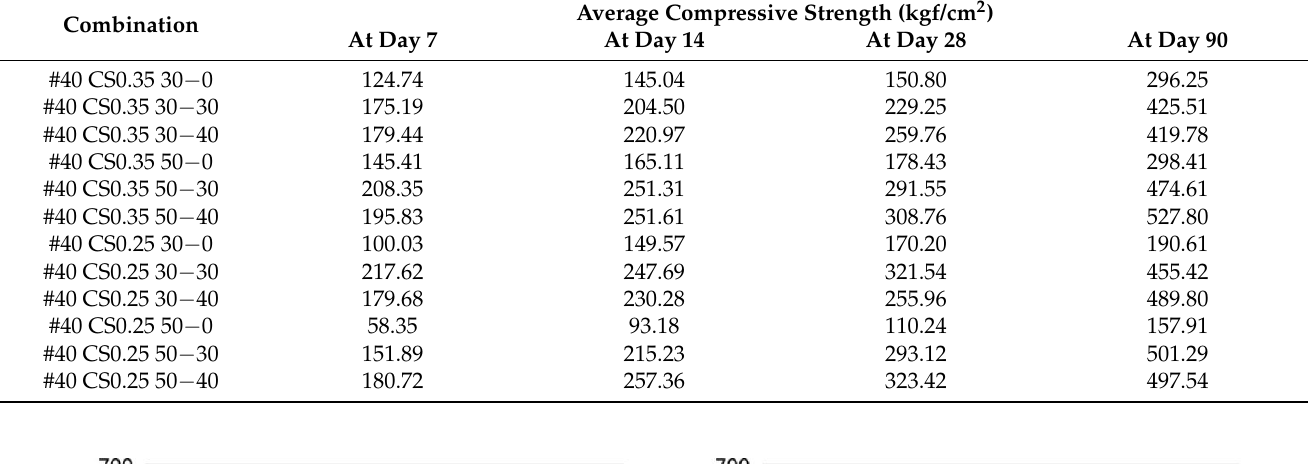
Table 6. Autoclave expansion results of different cement − sand ratios.